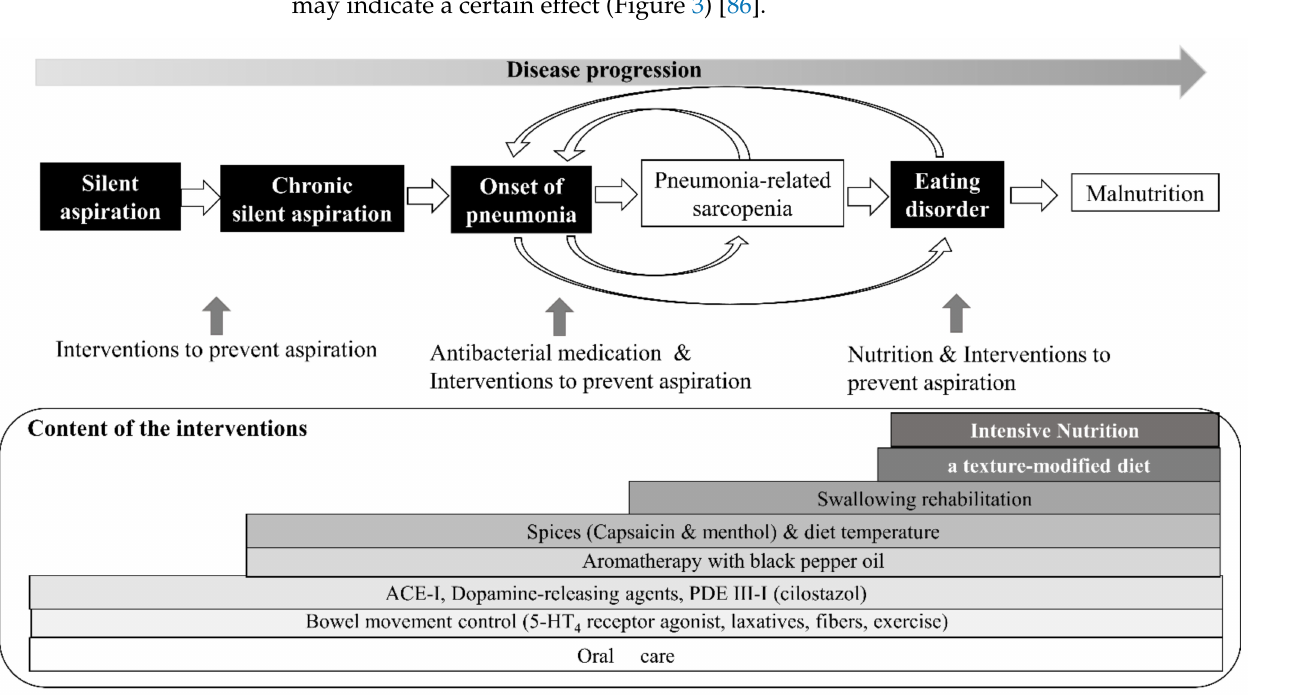
Figure 3. Disease time-axis and comprehensive